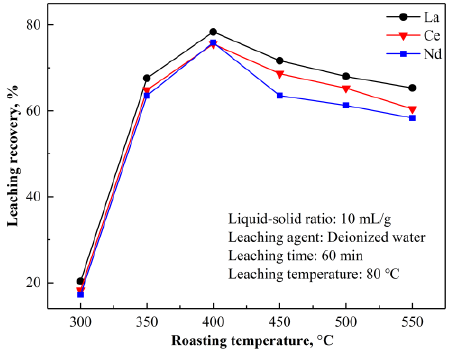
Figure 16. Effect of (NH 4 ) 2 SO 4 activation roasting temperature on the leaching recoveries of La, Ce, and